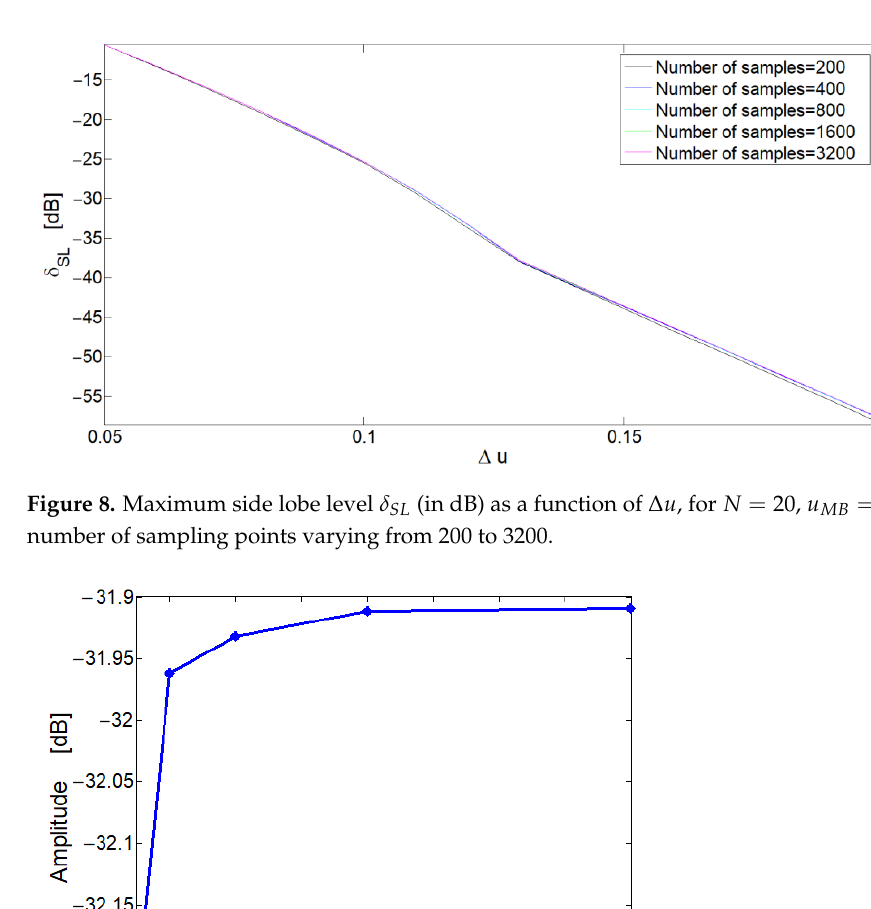
Figure 8. Maximum side lobe level 𝛿 𝑆𝐿 (in dB) as a function of Δ𝑢 , for 𝑁 = 20 , 𝑢 𝑀𝐵 = 0.16 , and the number of sampling points varying from 200 to 3200 .